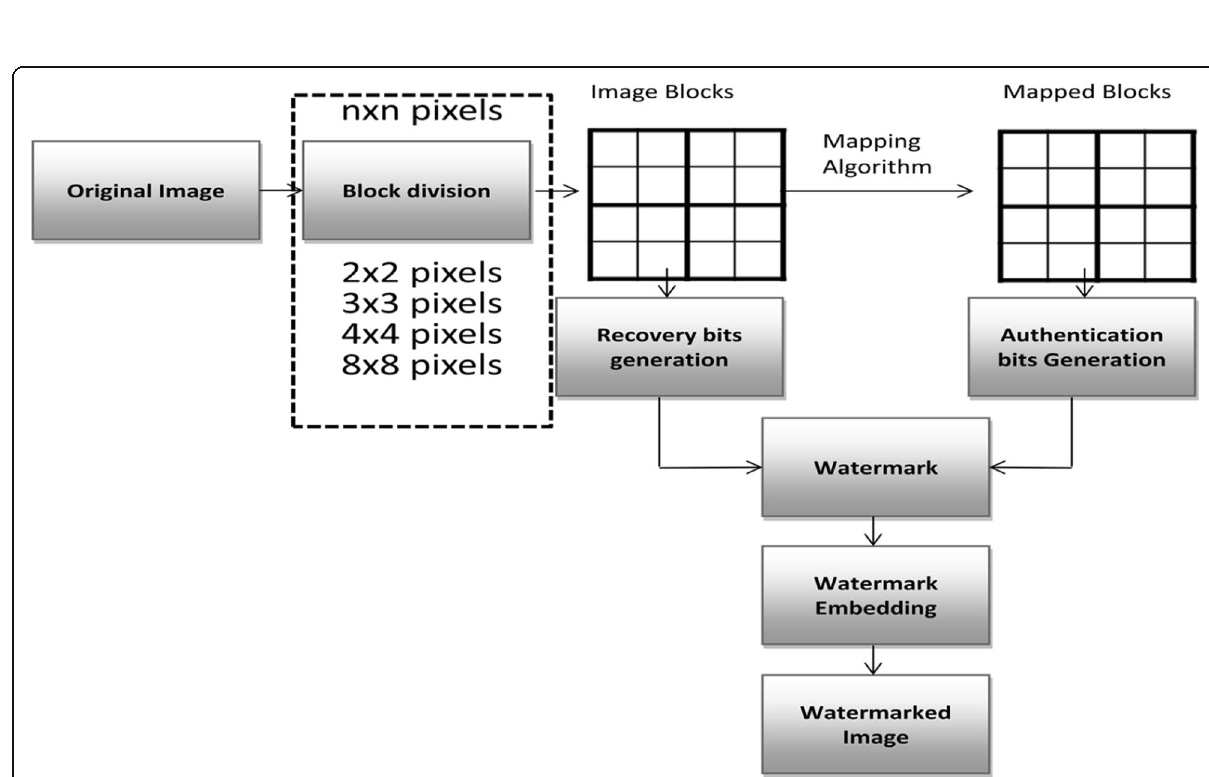
Fig. 4 Block diagram of the embedding procedure of Singh et al. [37], segmented block size modification-based fragile